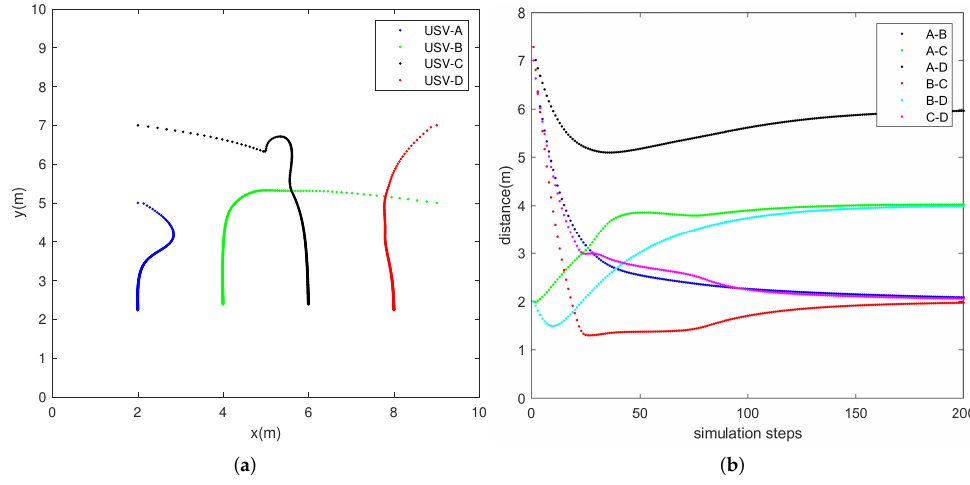
Figure 8. Data diagram of USVs formation in artificial potential field: ( a ) trajectory diagram of USVs during formation; ( b ) changes in the distance between USVs during the formation process.